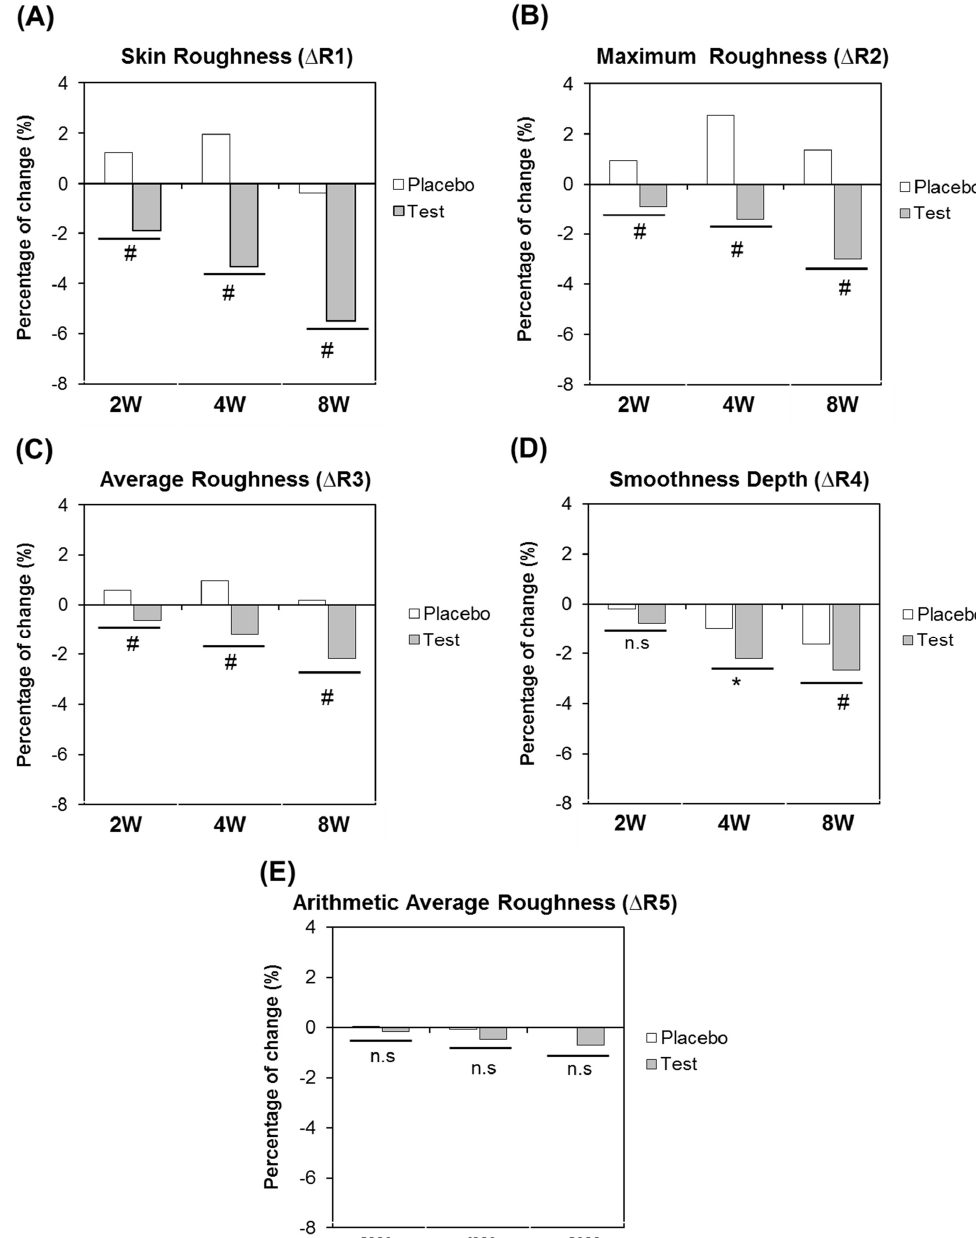
Figure 6. Changes of skin wrinkle parameters in crow’s feet following eight consecutive weeks’ application of test product (Mean ± SEM. * p < 0.05, # p < 0.01 vs. before treatment).